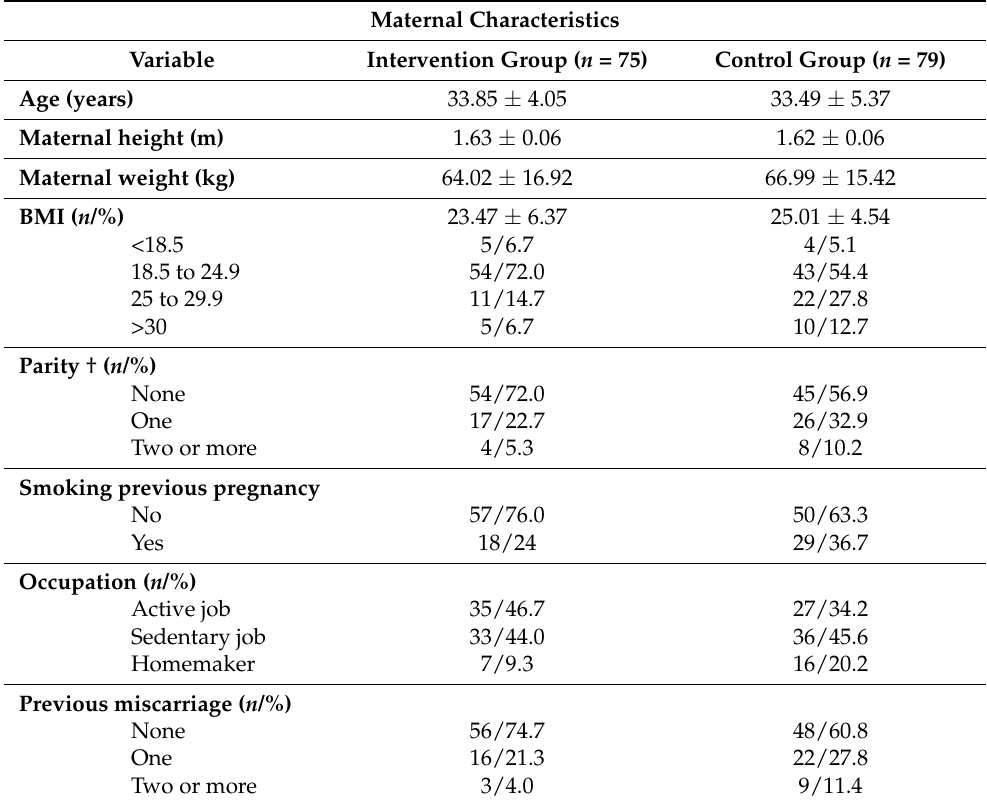
Table 1. Maternal